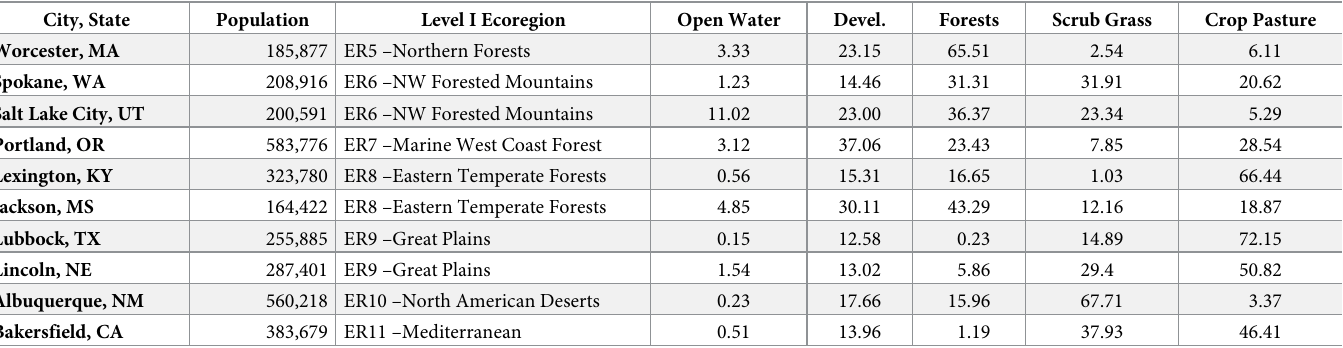
Table 1. Table of study cities.